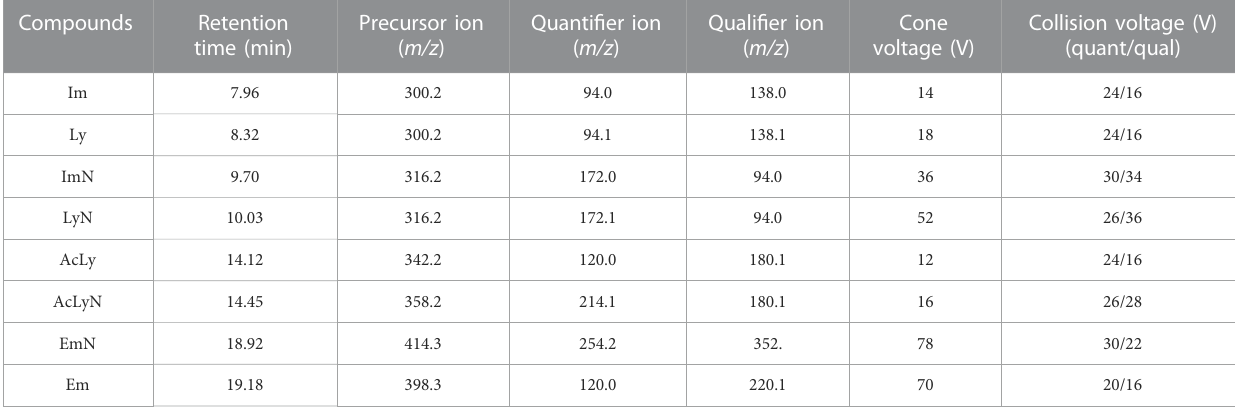
TABLE 2 Selected MRM transitions and compound parameters for the 8 PAs.